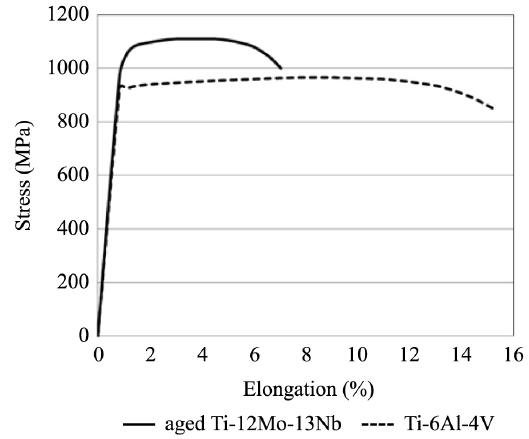
Figure 3. Stress-strain curves of aged Ti-12Mo-13Nb alloy and Ti-6Al4V alloy at room temperature and strain rate of 4 × 10 −3 s −1